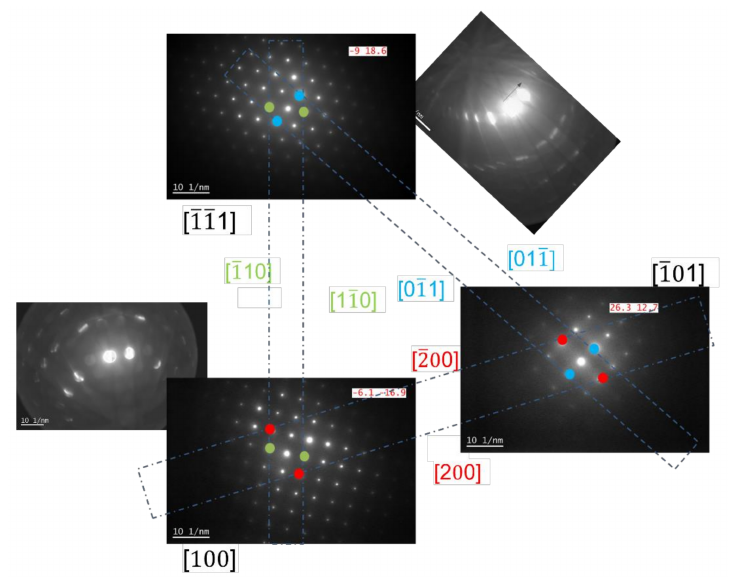
Figure 6. Kikuchi map between 3 zone-axes, including the values of the diffraction